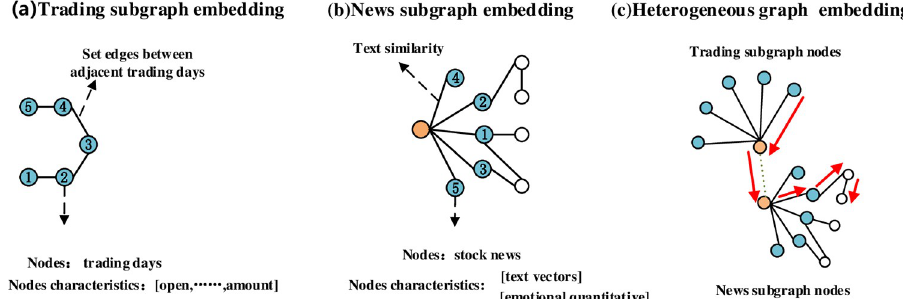
Fig 4. Graph fusion method ((a) trading subgraph embedding, (b) news subgraph embedding, and (c) heterogeneous graph embedding).